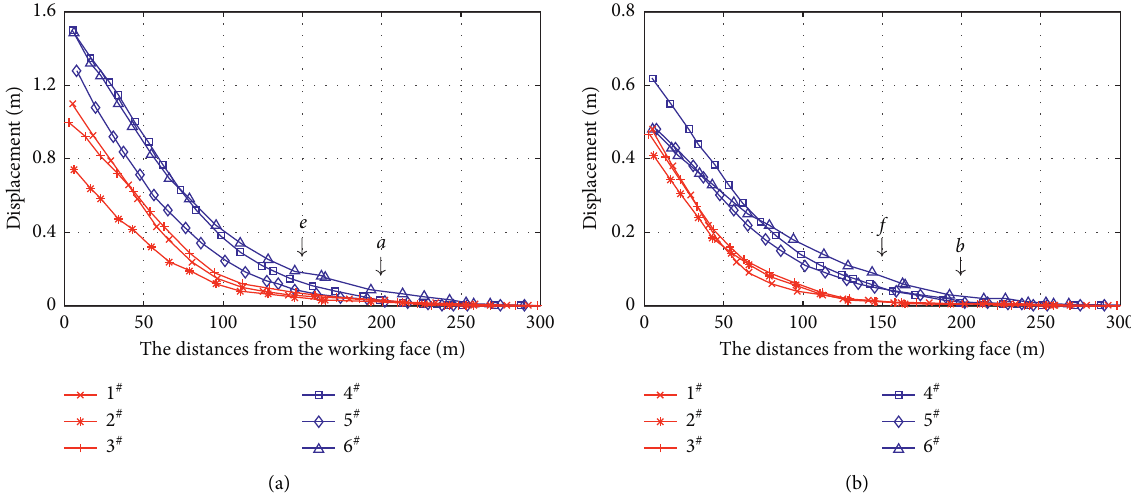
Figure 14: The surface deformation of the IRMR. (a) The displacement of the roof to floor. (b) The displacement of the tow